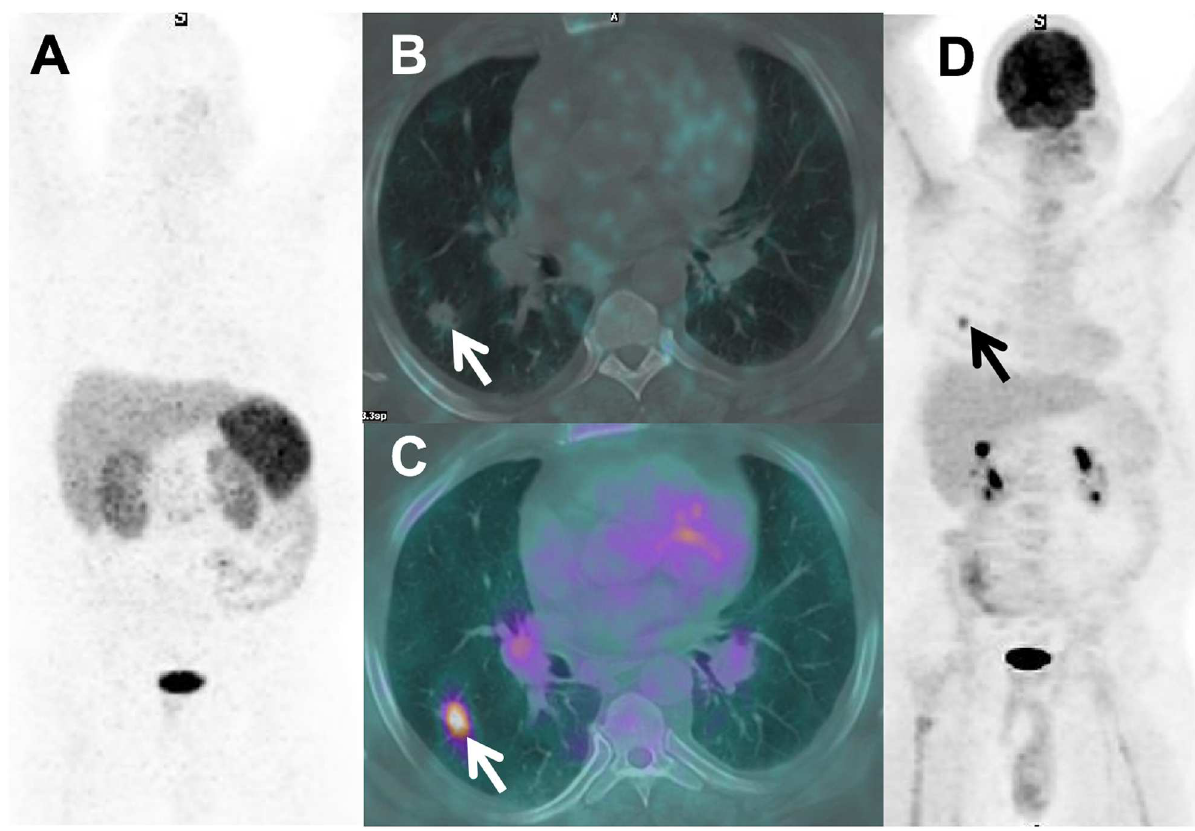
Fig 2. Discordant image, FP 18 F-FDG, TN 68 Ga-DOTATATE PET/CT. Axial CT (A) with a spiculatedIPN. Fused 18 F-FDG PET/CT (B) with IPN intenseuptake (SUVmax 5.8) vs. 68 Ga-DOTATATE (C) with no visibleuptake (SUVmax 0.90). Comparisonratios of the SUVmax of the noduleto normallung and aortic blood pool for 18F-FDG were 11.8 and 6.4, respectively, with corresponding values of 68 Ga- DOTATATE being 2.2 and 1.5. Biopsy revealedinflammatory cells; noduleresolved on CT follow-up.